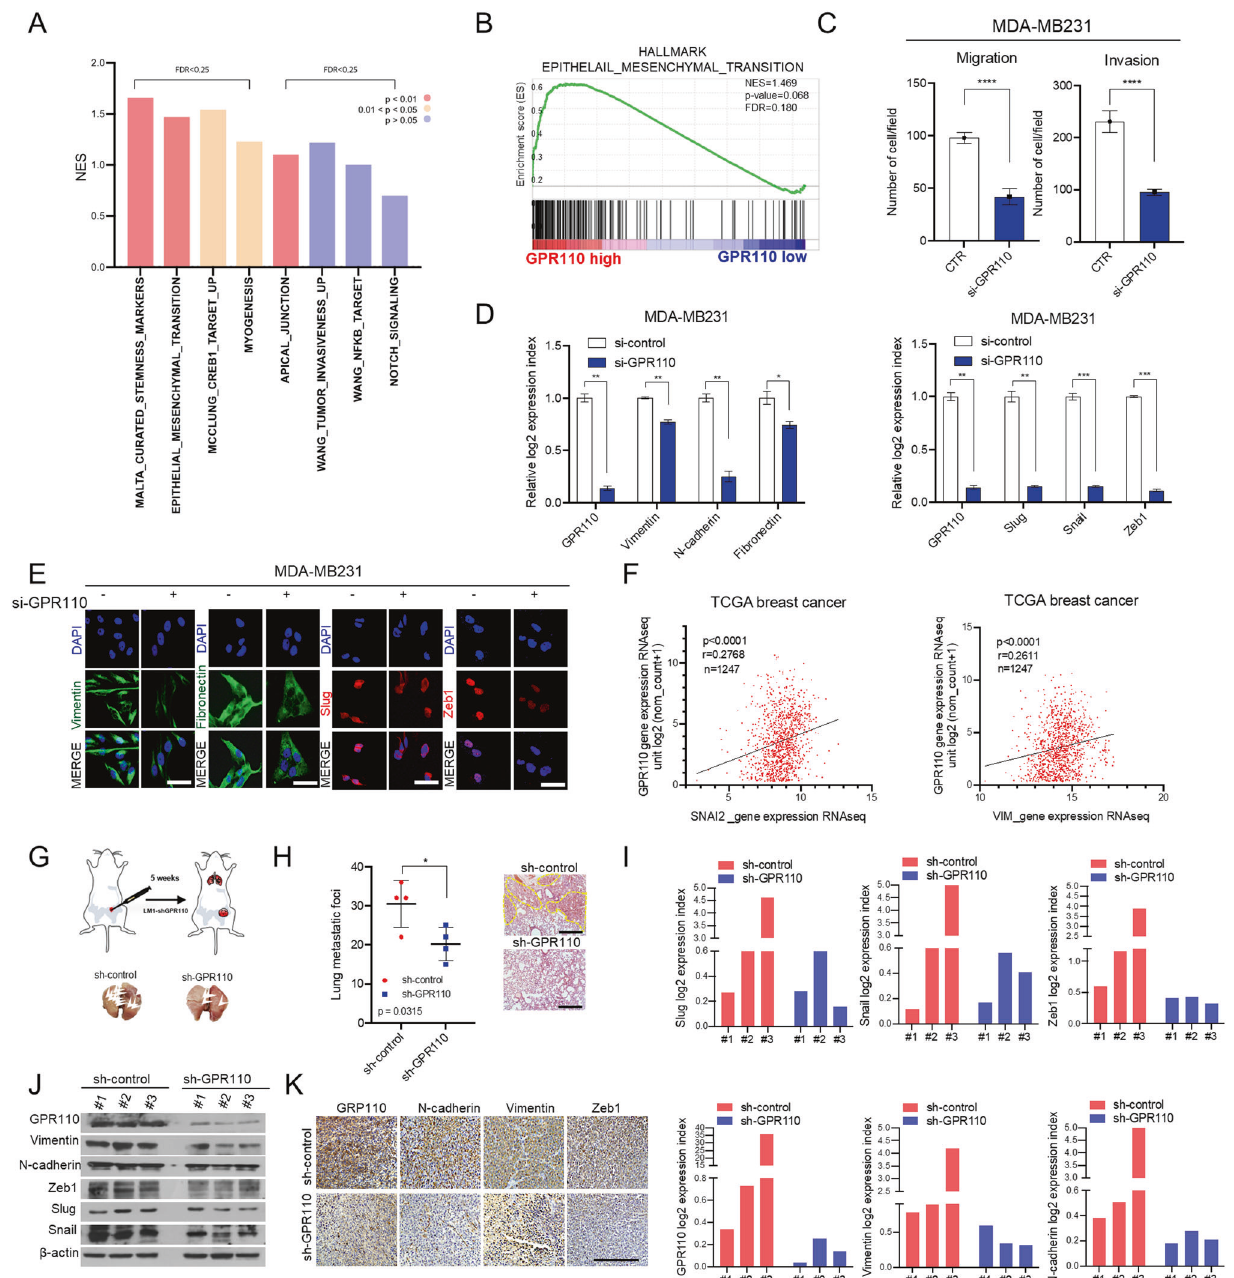
were performed after silencing GPR110 in MDA-MB231 cells. D qRT-PCR analysis showing EMT markers and regulators after knockdown of GPR110 in MDA-MB231 cells. E Representative images of ICC staining of Vim, Fn, Slug, and Zeb1 in MDA-MB231 transfected with si-GPR110. F A positive correlation between Slug and GPR110 was observed using the public TCGA database ( n = 1247). And a positive correlation between Vim and GPR110 was observed using the public TCGA database ( n = 1247). G , H After injection into fat pad of female NOD/SCID mice, the image of mouse lungs and representative image of H&E staining of lung metastasis and the number of lung metastatic foci. I , J qRT- PCR analysis and Western blotting of EMT markers and regulators using mouse tissues. K IHC analysis of EMT markers and regulators in xenograft tumor of mice. Scale bar = 100 μ m. β -actin was used as a control for normalization of expression. * p < 0.05, ** p < 0.001, *** p = 0.0001 and **** p < 0.0001; ns not signi fi cant; determined by two-tailed Student ’ s t test (95% con fi dence